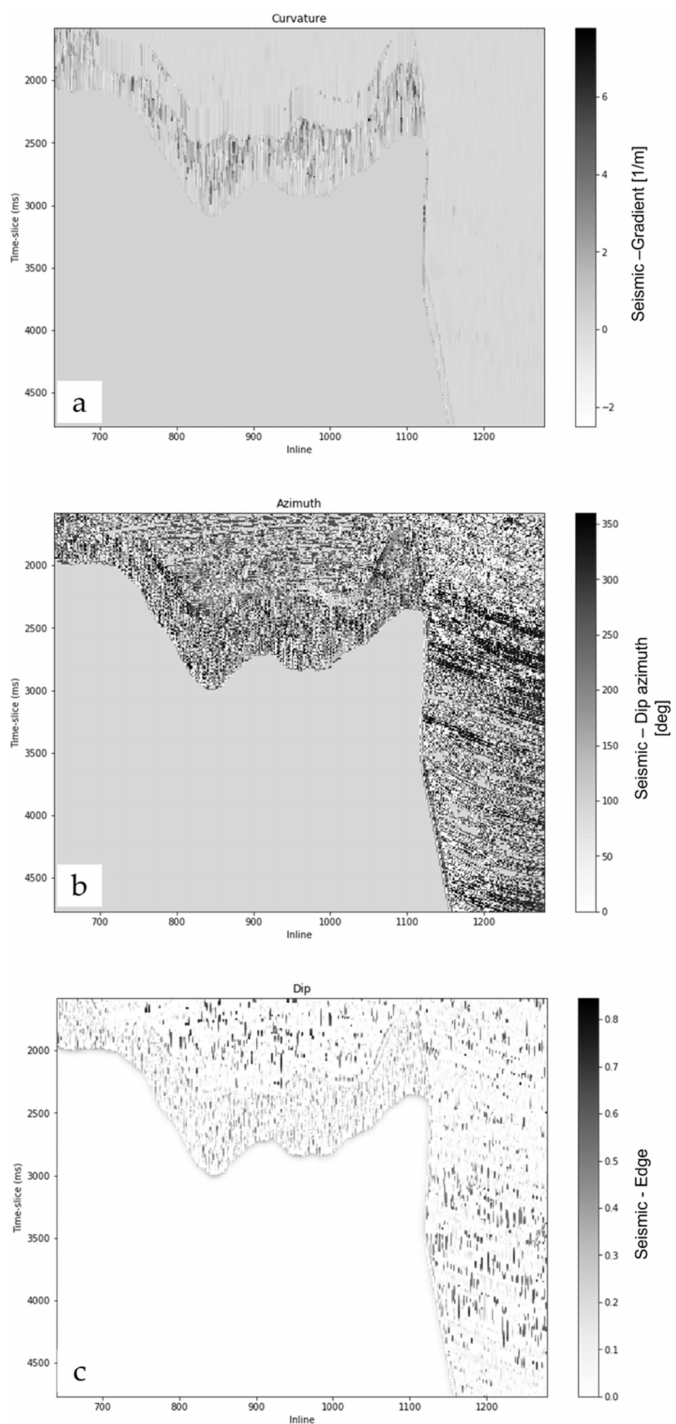
Figure 9. The extracted seismic attributes for salt delineation including ( a ) curvature, ( b ) azimuth, and ( c )